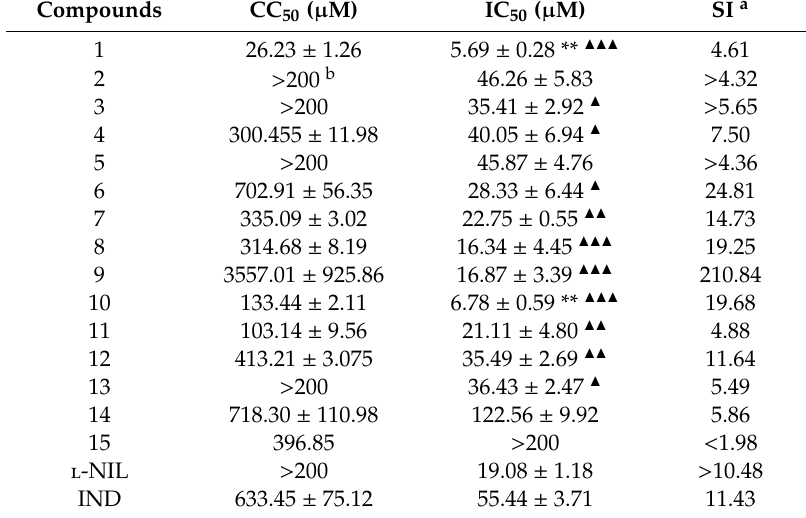
Table 4. The inhibitory activity of 15 compounds on nitric oxide (NO) production ( n = 3).